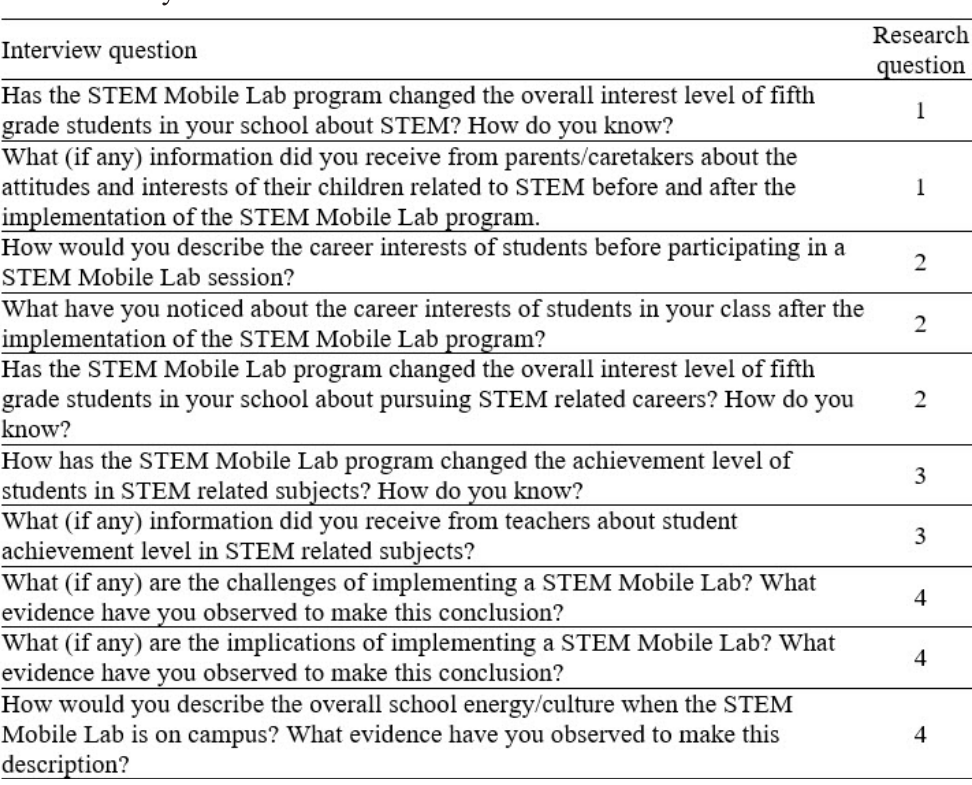
Table 3. Administrator structured inter-view questions and the alignment to the re-search questions of the